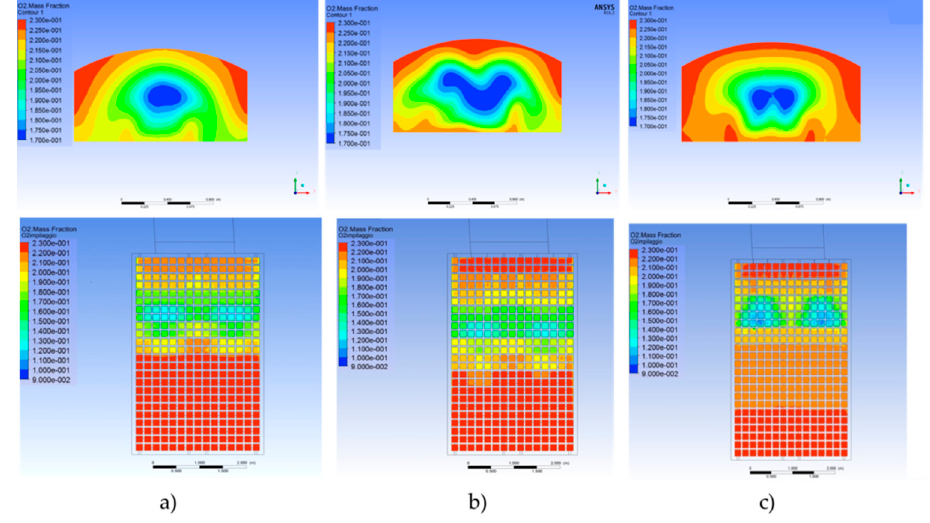
Figure 17. O 2 mass fraction contours—( a ) first case ( b ) second case ( c ) third case.